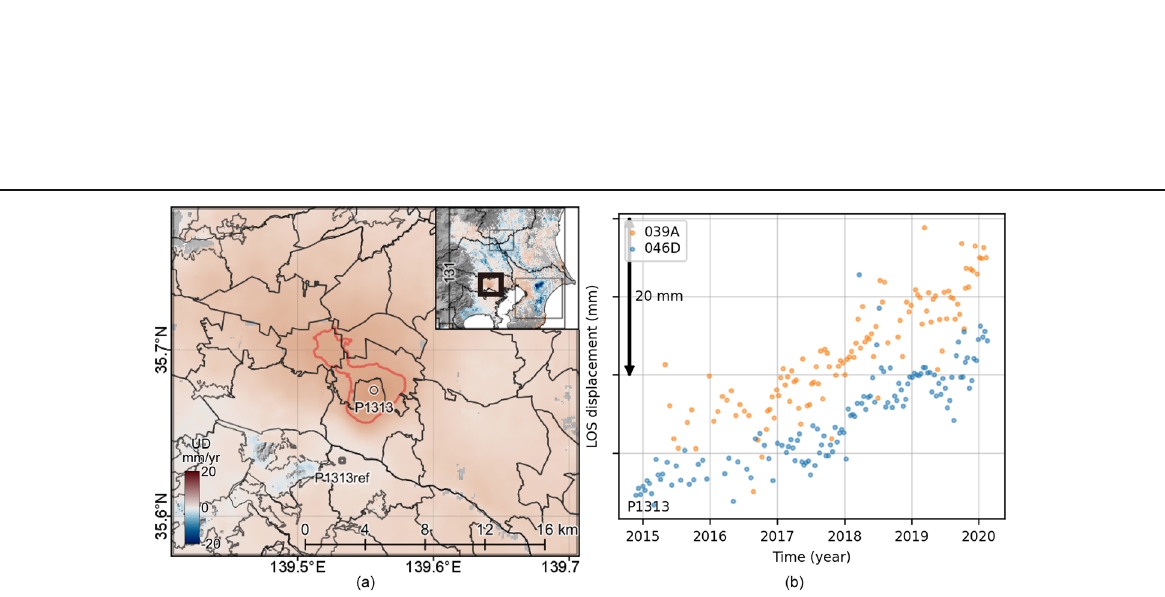
Fig. 12 a Vertical deformation velocities in Chofu (ID: 131, Tokyo in Kanto). The black lines denote the outlines of the DID. The interval of the red (uplift) contour lines is 5 mm/year without the 0 mm/year lines. The inset denotes the whole area of the 131 Kanto. b LOS deformation time series at P1313 with reference to P1313ref for each